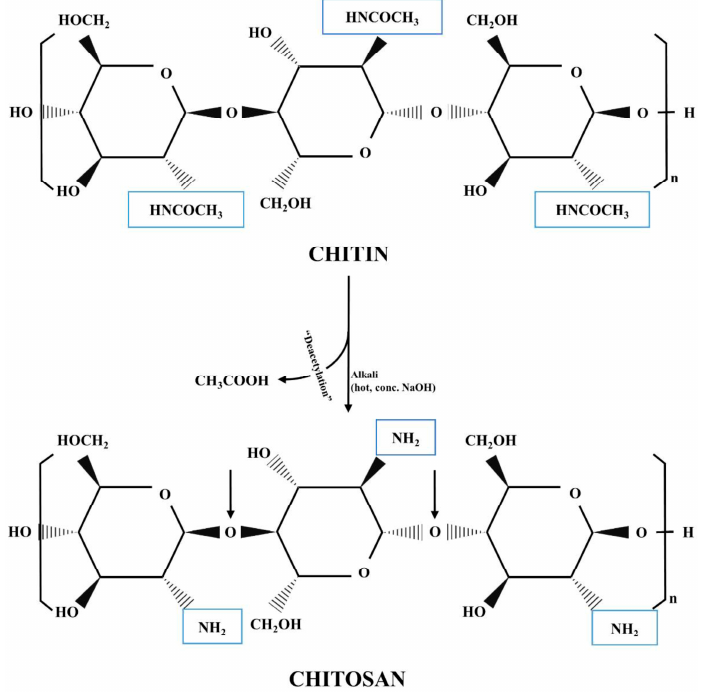
Figure 2. Comparison of the chemical structure of chitin and chitosan [62].